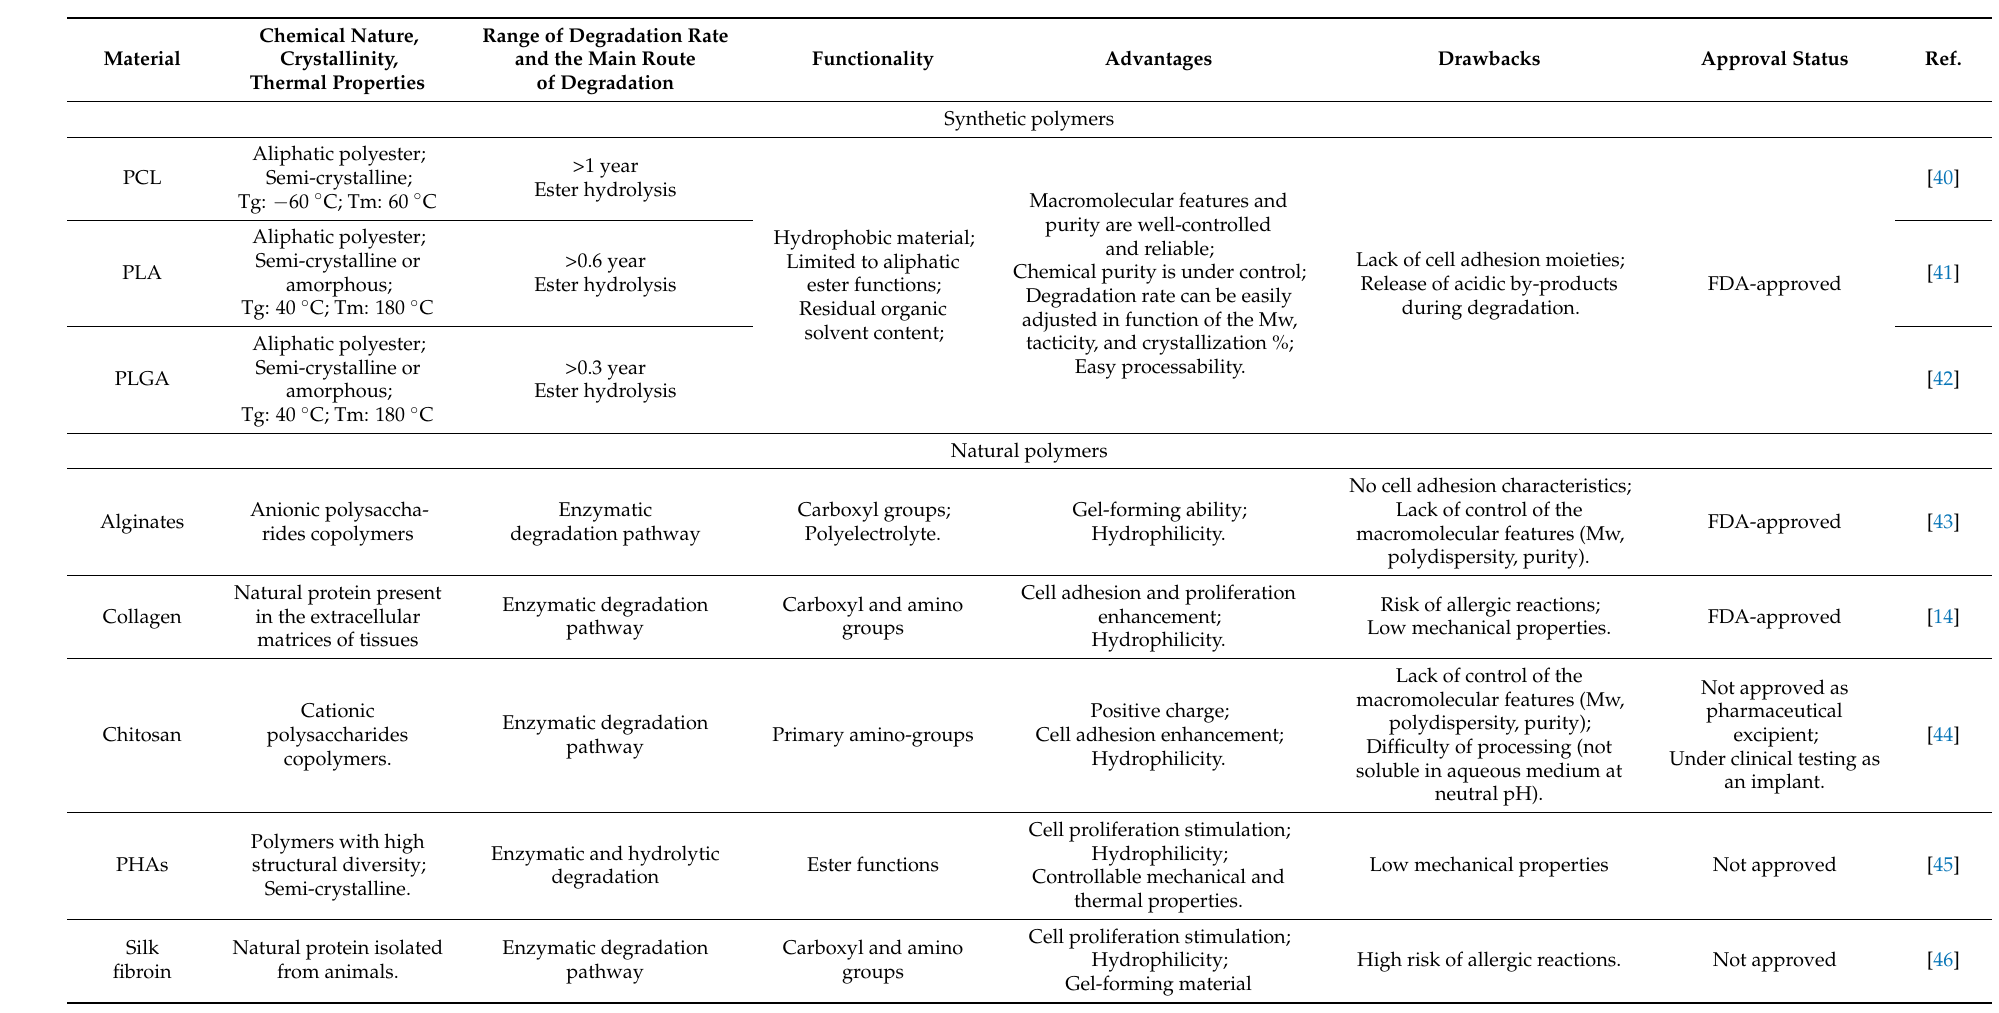
Table 1. Biodegradable biomaterials for MPs